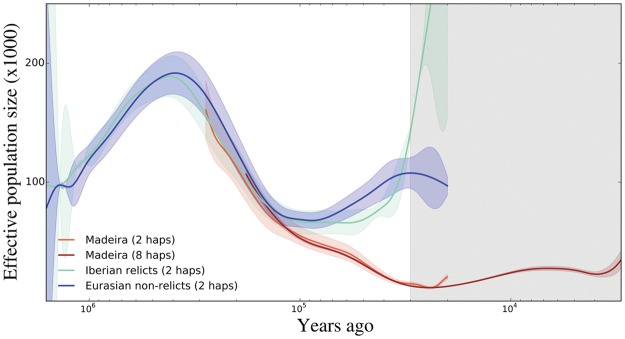
Effective population size as a function of time (Ne(t)) in Madeira (two shades of red), Iberian relicts (green) and Eurasians (blue). Inference from MSMC is shown for Madeira in two- and eight-haplotype mode, respectively, in the time frame between 20 and 300 ka, and between 3 and 200 ka. Madeiran Ne is not shown at more ancient times because of inference limitations in small populations (see Materials and Methods, and supplementary fig. S2, Supplementary Material online). Inference from MSMC for Iberian relicts and Eurasians is shown between 20 ka and 1.6 Ma. Iberian relicts represent also the ancestral population in common with Madeira, before ∼70–85 ka. Ne(t) is shown smoothed with a cubic spline across median Ne for each time segment used in MSMC. Shaded areas represent confidence intervals (± 1.96 · SE). The gray area shades inference in two-haplotype mode that are less reliable in the recent past (Schiffels and Durbin 2014).